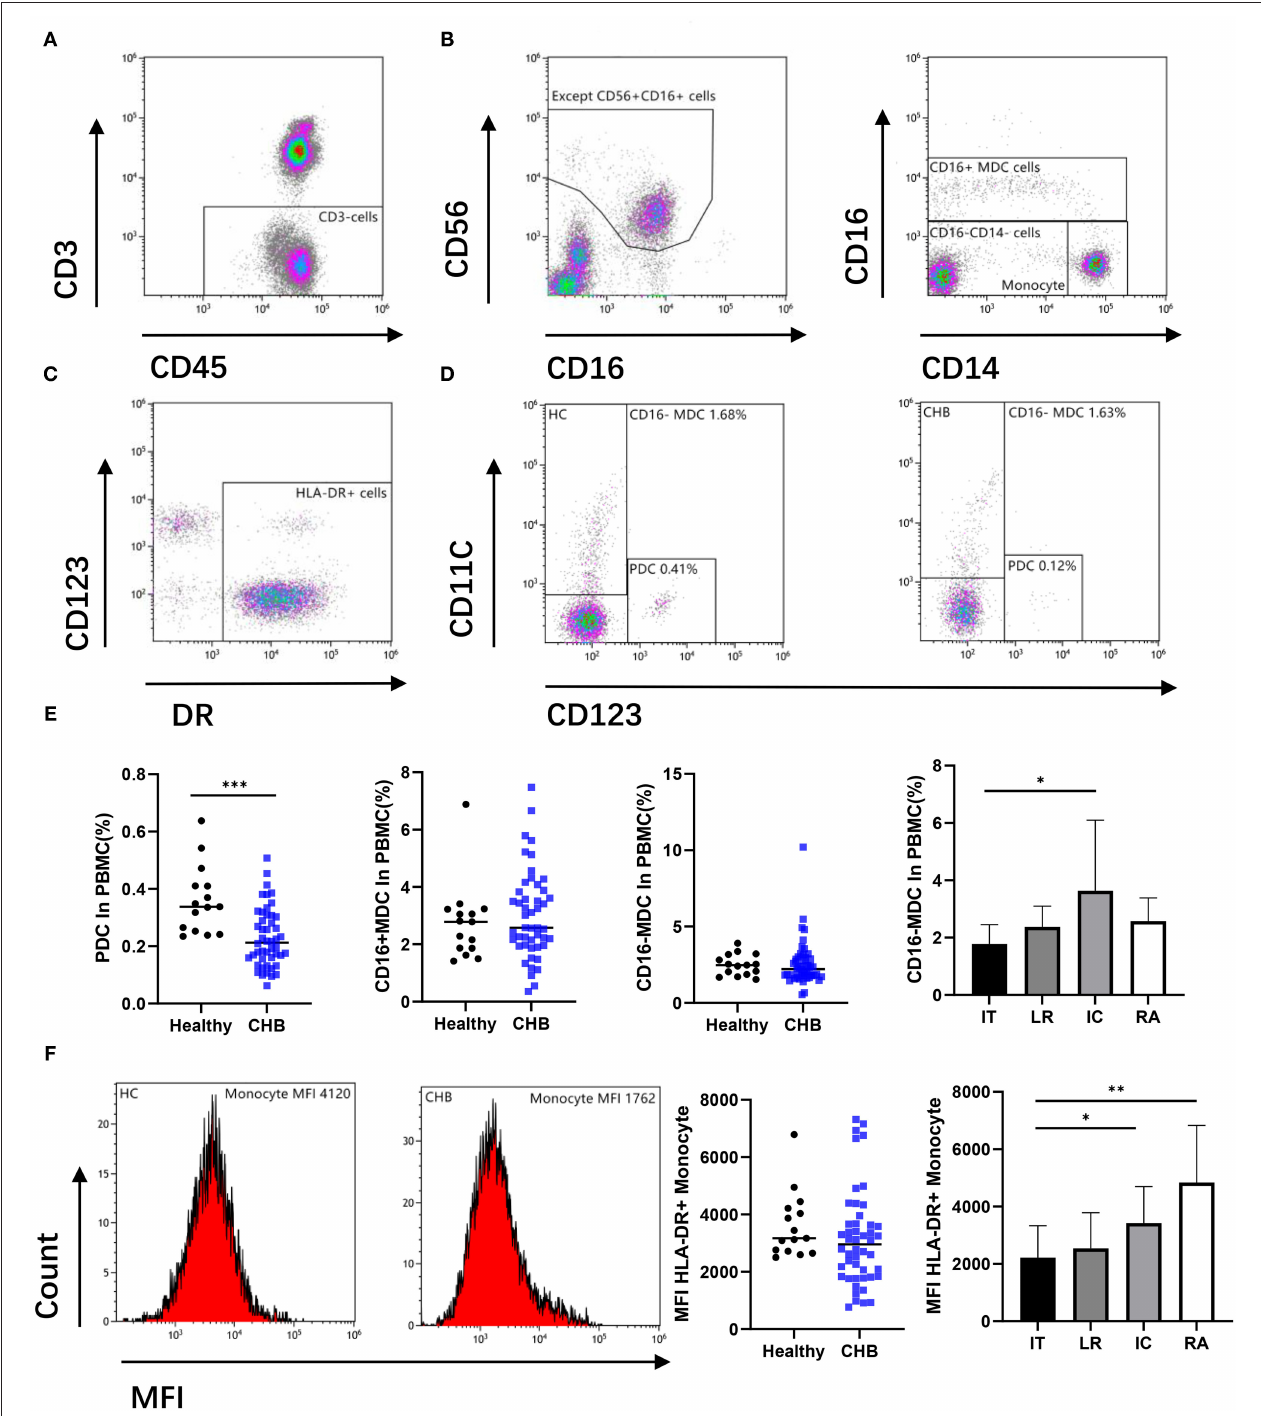
FIGURE 1 | Antigen-presenting cells (APCs) were altered during chronic hepatitis B virus (HBV) infection. (A,B) Remove the CD56 positive cell from the CD3 negative gate, and the remaining parts were divided into CD16 + myeloid dendritic cell (MDC), Monocyte, and CD16–CD14– cell. (C,D) Circle the DR positive cells from CD16 and CD14 double negative cells, there are CD123 + (plasma dendritic cell, PDC) and CD11c + (CD16– MDC) cells among them. Representative flow cytometry plot indicates the percent frequencies of PDC as well as CD16– MDC in healthy ( n = 15) and CHB patients ( n = 48) respectively. (E) According to different alanine aminotransferase (ALT) and HBV DNA levels, all chronic hepatitis B (CHB) were divided into immune tolerant (IT; n = 13), lower replicative (LR; n = 13), immune clearance (IC; n = 12) and reactivation (RA; n = 10). The percentages of PDC and MDC in different groups were compared. (F) Mean fluorescence intensity (MFI) of DR in CD14 + CD16– Monocyte cell was compared. Each data point represents an individual subject. Horizontal lines show the median. Statistically significant differences are indicated by * p < 0.05; ** p < 0.01; *** p < 0.001.